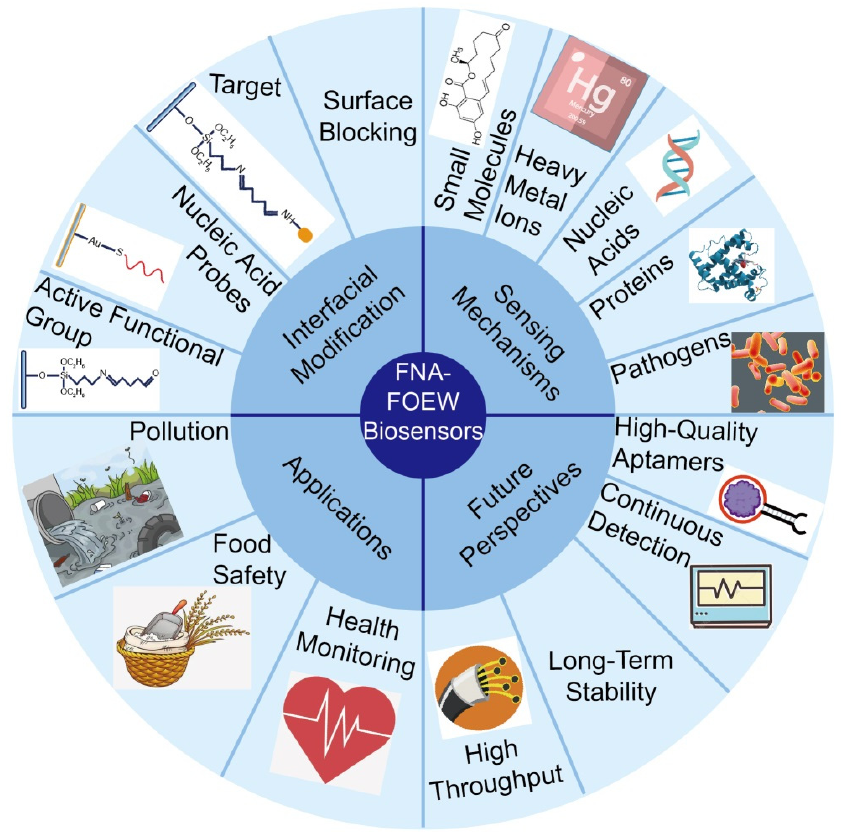
Figure 1. Scheme diagram of the content of this review.